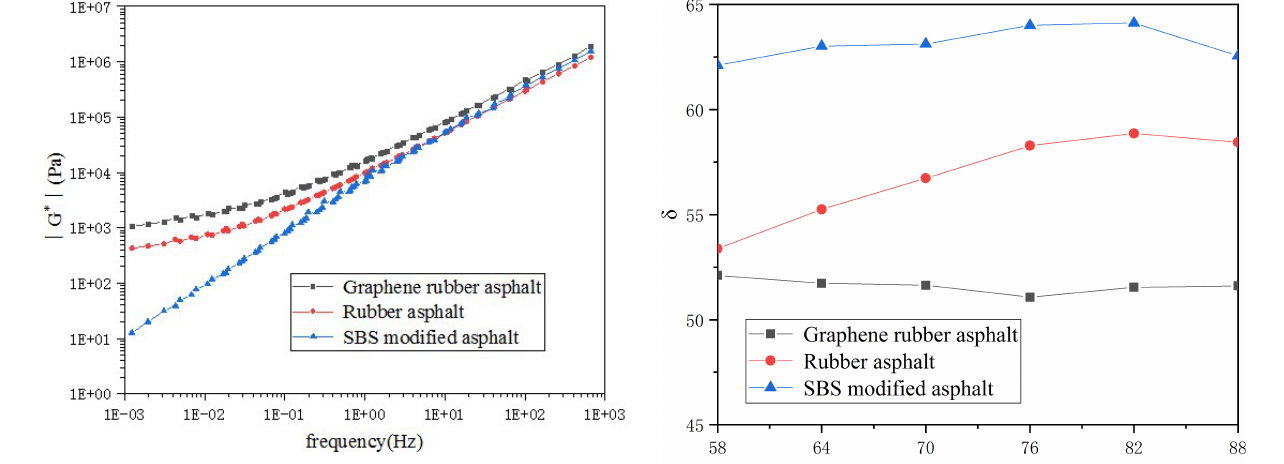
Figure 3: The complex modulus master curve of 40 ∘ C